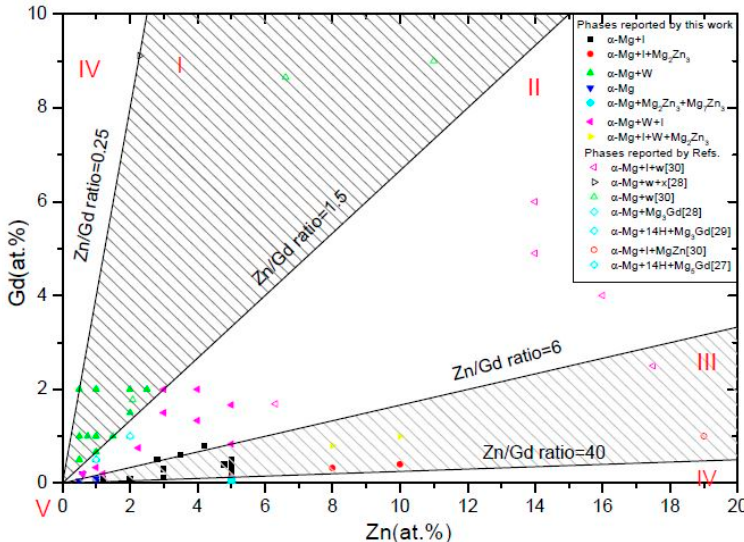
Figure 2. Phase formation of Mg-Zn-Gd alloys on the Mg-rich corner (Zn0~20 at.%, Gd 0~10 at.%): (I) α -Mg+W-phase(+binary compounds), (II) α -Mg+W-phase+I-phase(+binary compounds), (III) α -Mg+I-phase(+binary compounds), (IV) α -Mg+binary compounds, and (V) α